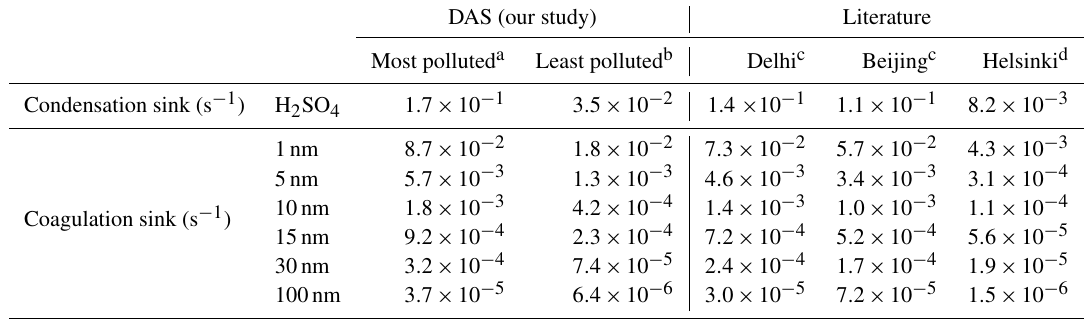
Table 2. Characteristic coagulation and condensation sinks for Delhi and comparison with those calculated using PSDs in the literature for other